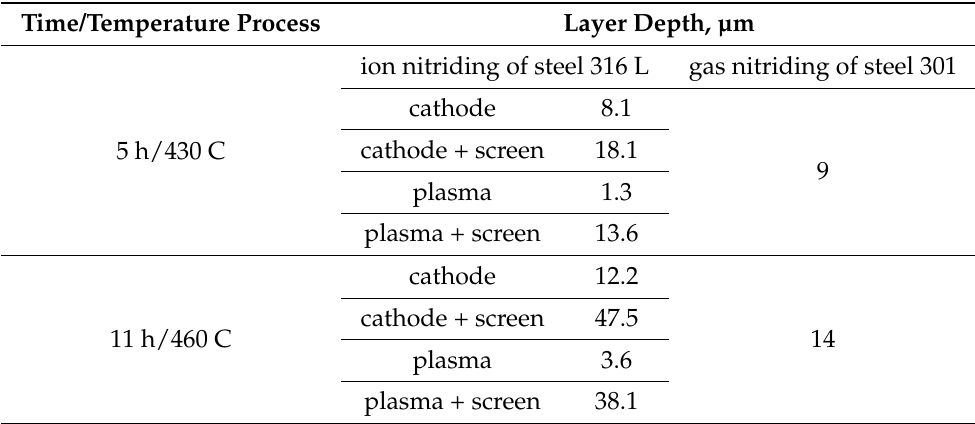
Table 1. A comparison of the obtained effects of the glow discharge nitriding process in various discharge areas with the conventional gas nitriding process [21]—measurement with the GDS GD PROFILER HR